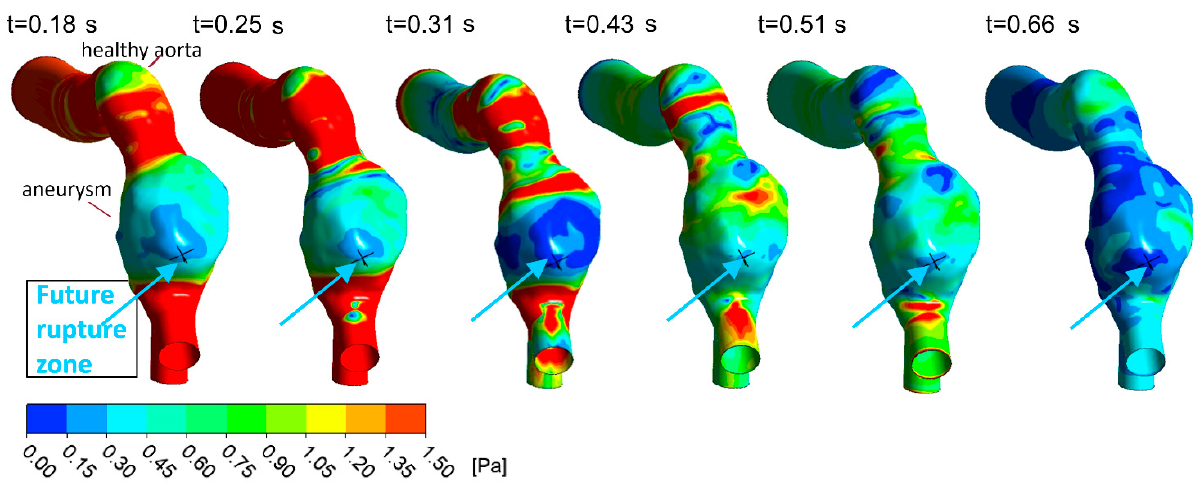
Figure 7. WSS contours distribution in the rupturing aneurysm at the selected instants of the cardiac cycle ( t = 0.18 s, t = 0.25 s, t = 0.31 s, t = 0.43 s, t = 0.51 s, and t = 0.66 s). The arrow and the black cross indicate the future rupture point.